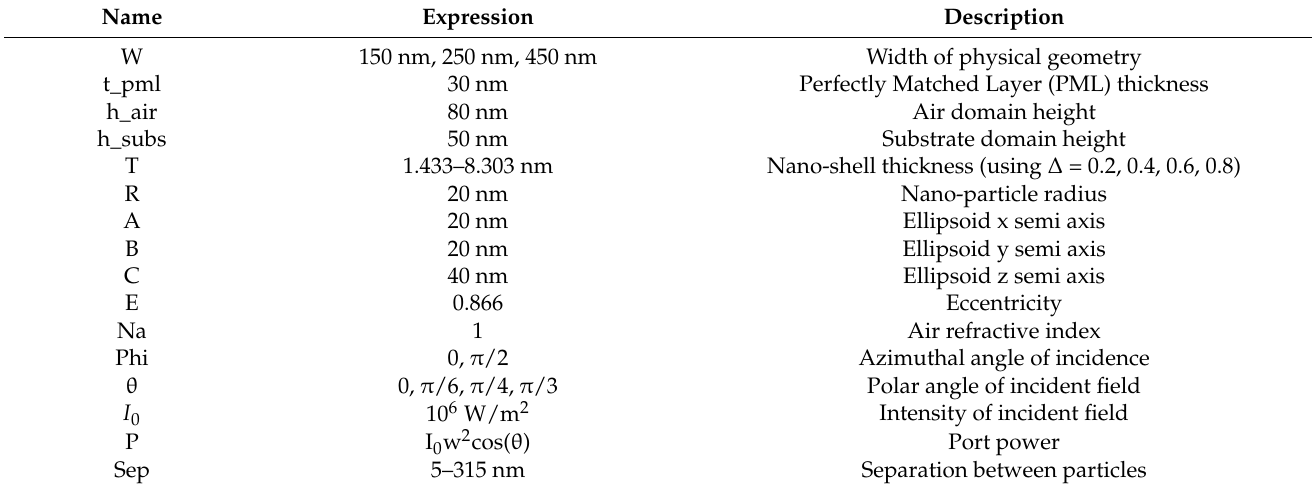
Table 1. Parameters for all geometries and parametric sweeps.